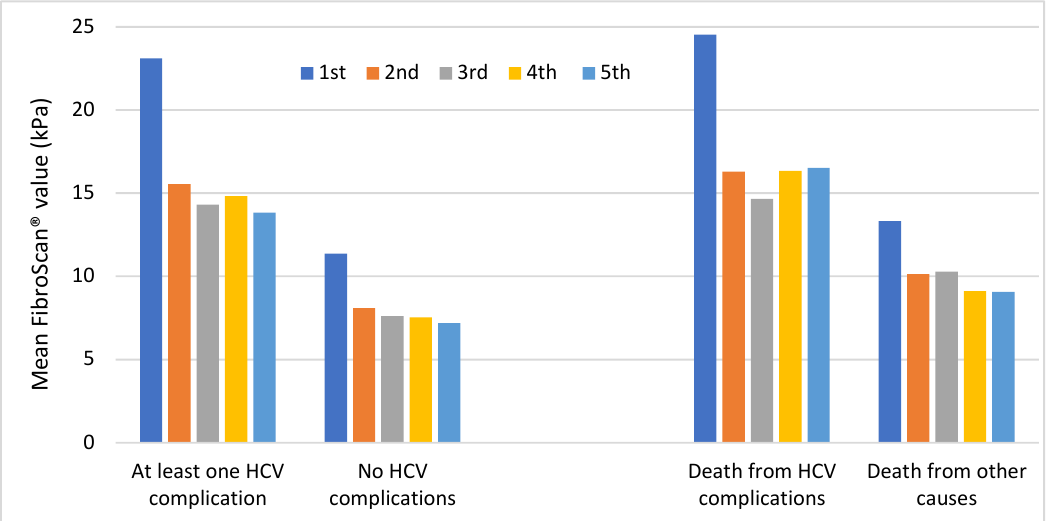
Figure 7. Trend of mean FibroScan ® values in patients with at least one HCV complication vs. patients without HCV complications throughout the follow-up period ( left ). Trend of mean FibroScan ® values in patients who died from HCV complications vs. patients who died from other causes throughout the follow-up period ( right ). HCV, hepatitis C virus.